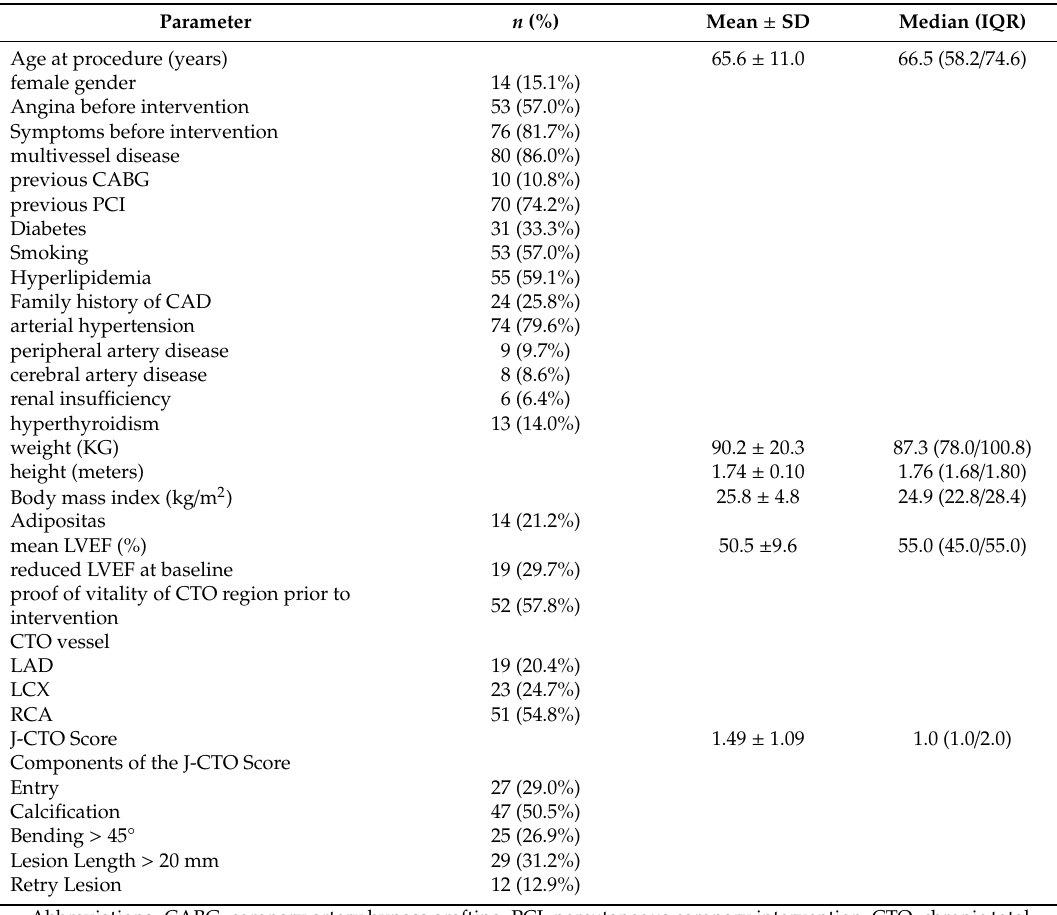
Table 1. Baseline characteristics ( n =